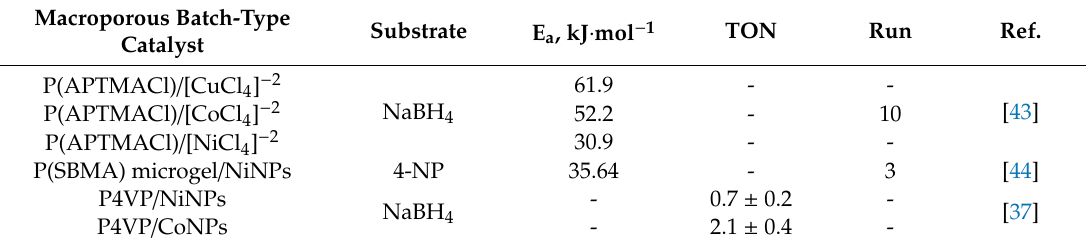
Table 3. Kinetic parameters of NaBH 4 hydrolysis and hydrogenation of aromatic nitrocompounds over macroporous batch-type catalytic reactors.